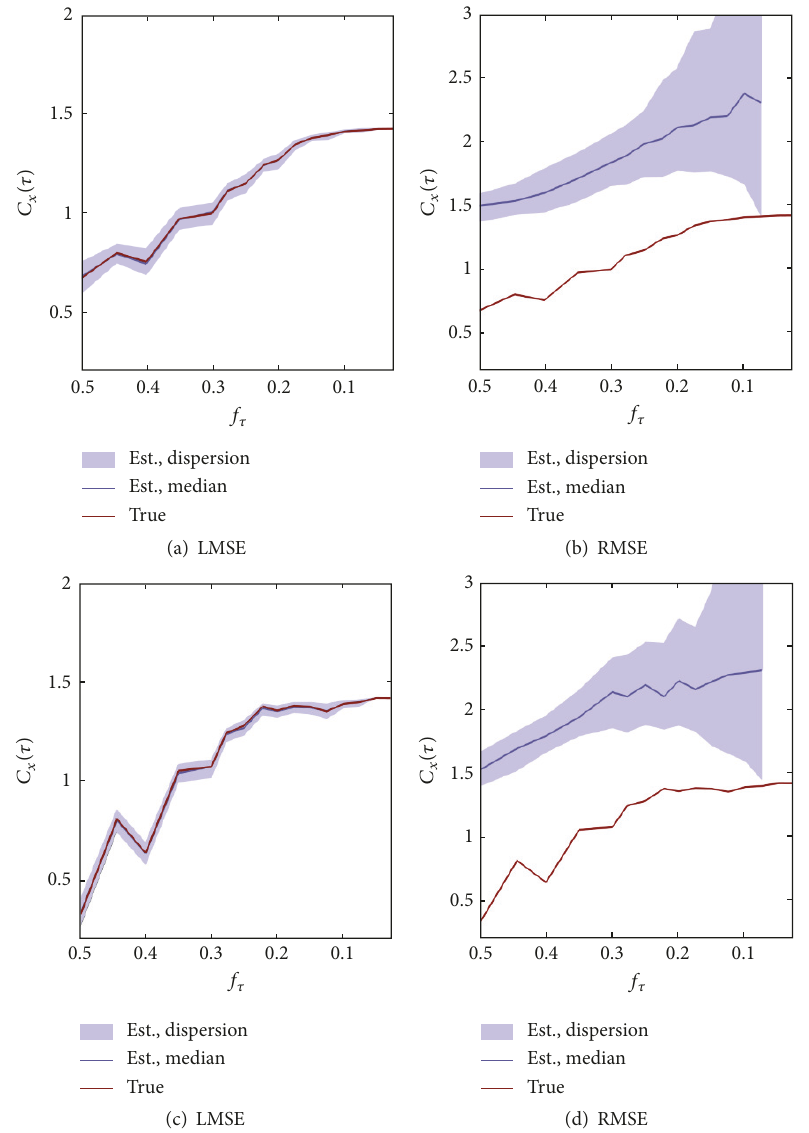
Figure 2: Estimation of multiscale entropy (MSE) over finite-length realizations of simulated AR processes. Plots depict the exact values (red lines) and the distributions (median and 10th–90th percentiles) of the MSE estimates ( 𝐶 𝑥 (𝜏 𝑠 ) ) computed as a function of the cutoff frequency ) for representative parameter settings of Type 1 simulation of the low-pass filter used to eliminate the fast temporal scales of the process (𝑓 𝜏 𝑠 (a, b) and of Type 2 simulation (c, d). Estimates are obtained using the linear MSE (LMSE) method proposed in this study (a, c) and using the refined MSE (RMSE) method proposed in [11] (b, d). In simulated AR processes, RMSE estimates exhibit high bias and a variance increasing with the time scale, while LMSE estimates display high computational reliability at all time